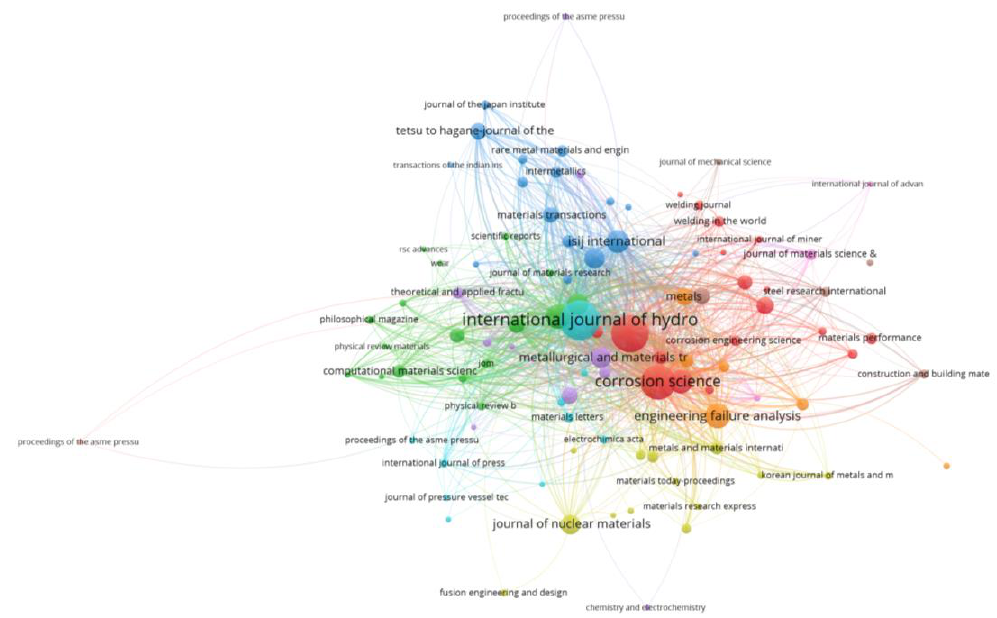
Energies 2022 , 15 , x FOR PEER REVIEW